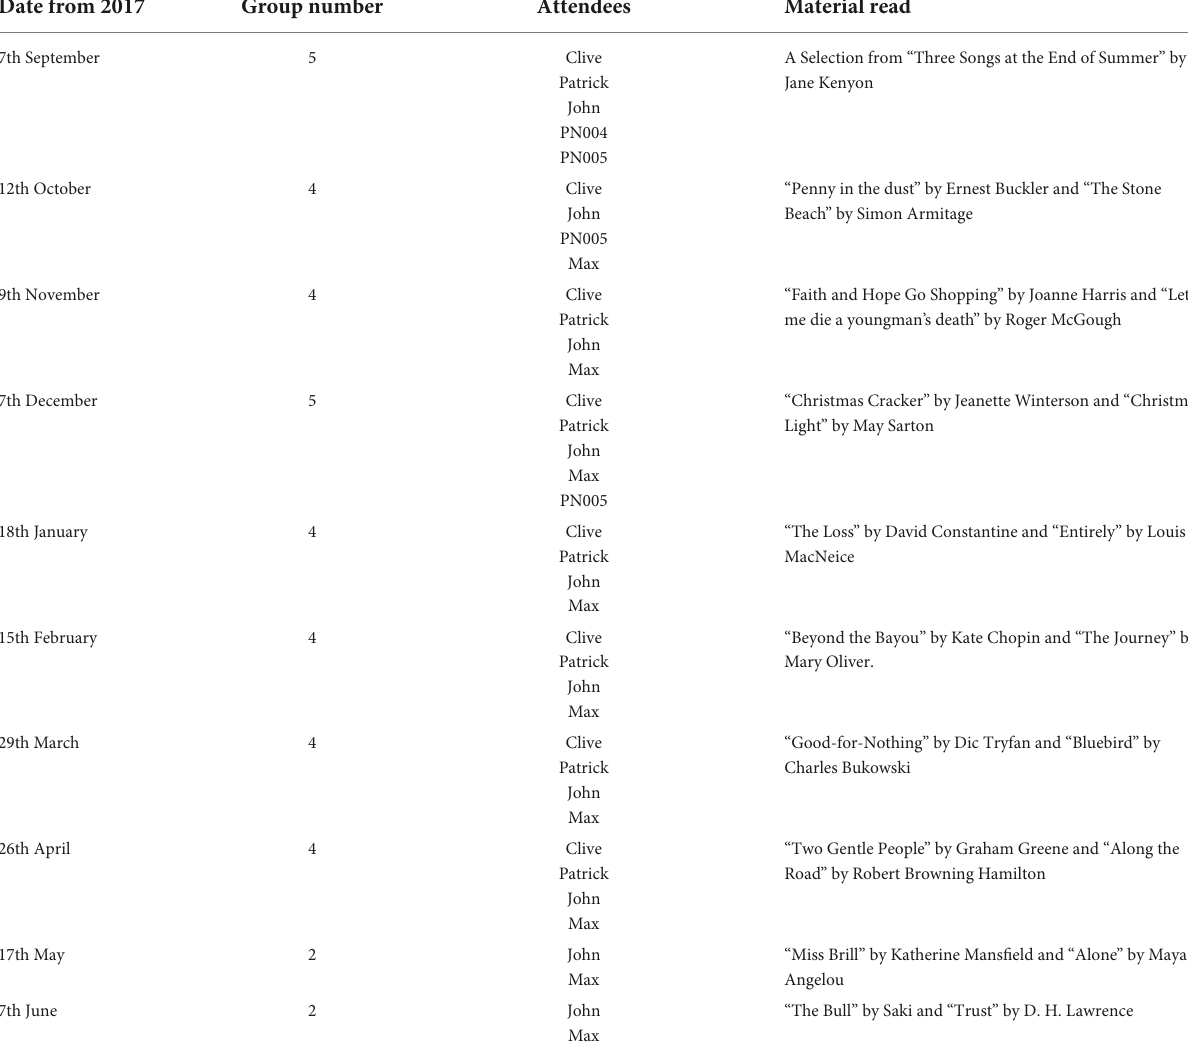
TABLE 1 Record of sessions and material forming corpus for